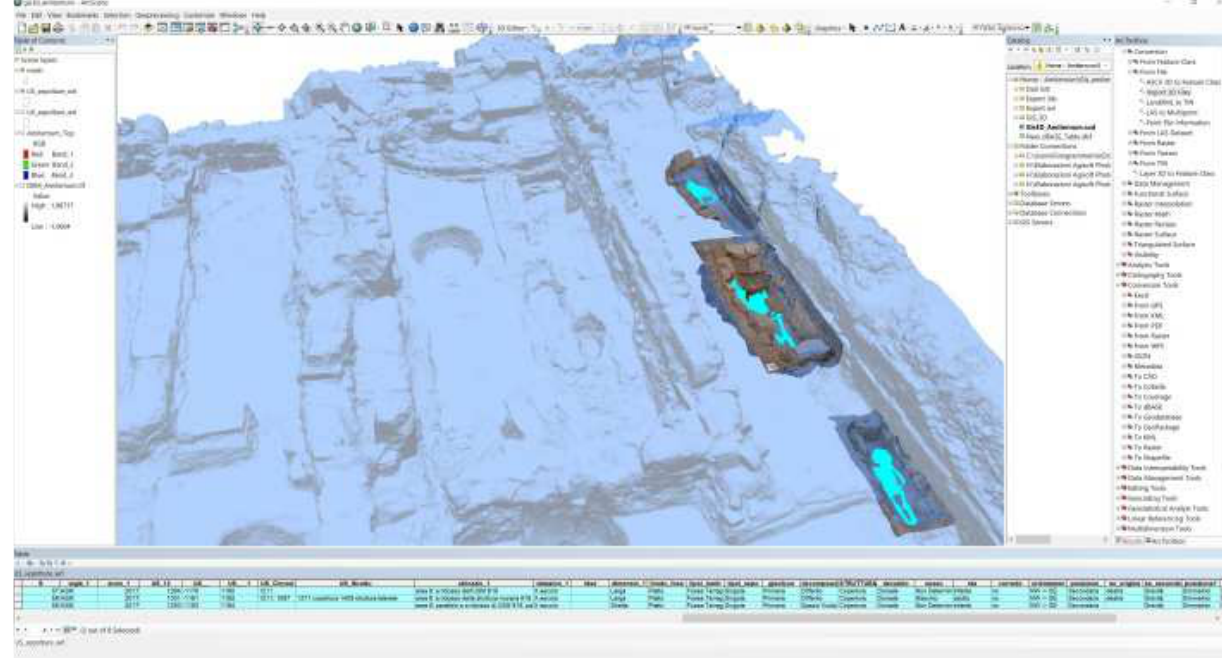
Figure 6. Screenshot from the Esri ArcScene software with highlighted skeletons and related